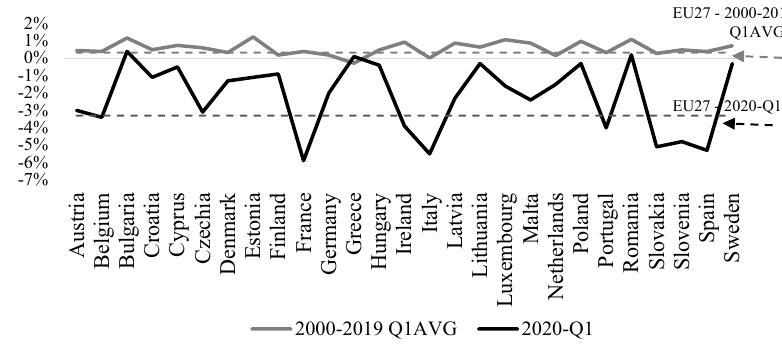
Figure 4: Q1 - GDP evolution for EU 27 countries. Source: Authors ’ elaboration based on data from